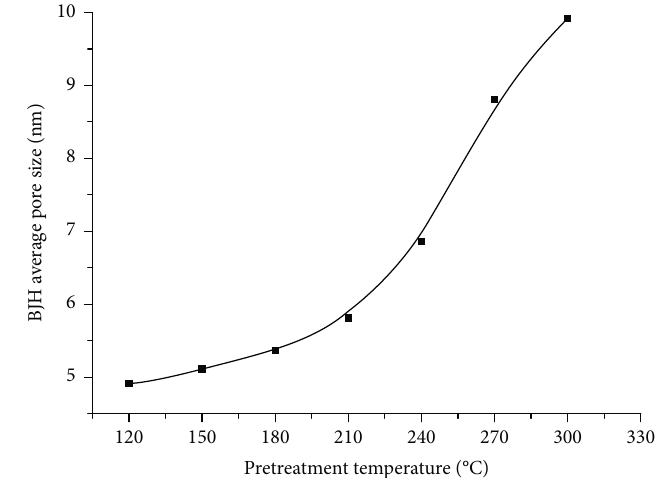
Figure 2: The dynamic change of the average pore sizes under various pretreatment